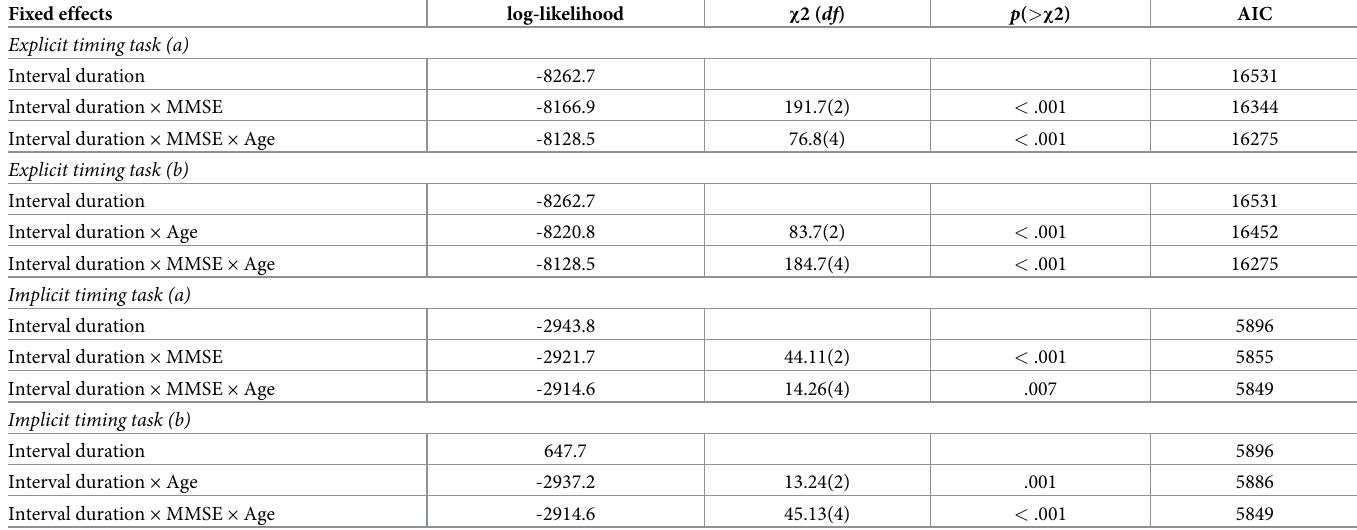
Table 1. Model comparison for the explicit and implicit timing tasks showed that the best fitting model was the full model including the interval duration and both the MMSE score and age variables.